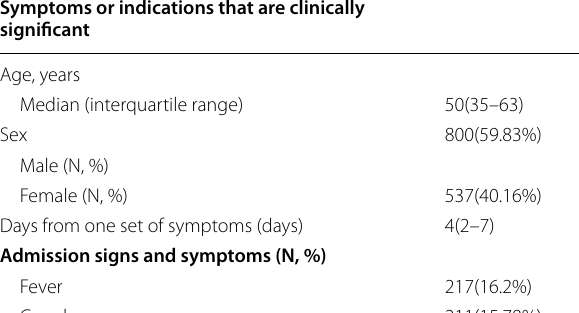
Table 1 COVID‑19 patients’ clinical presentation and